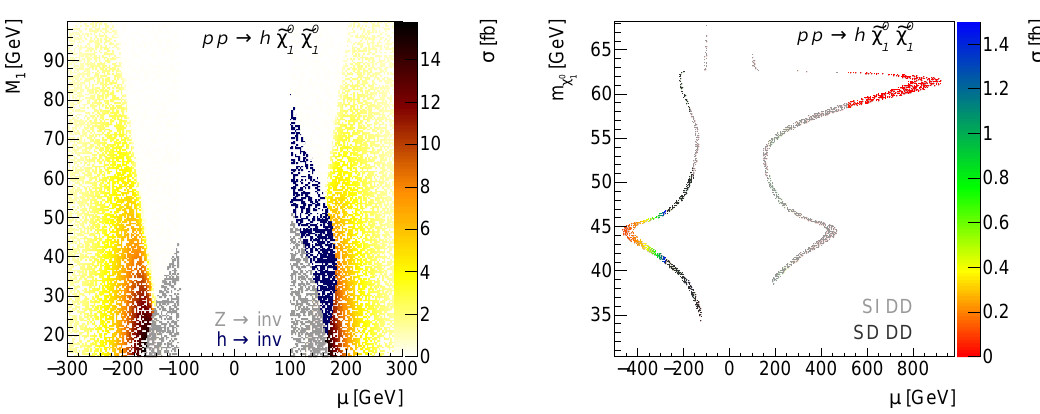
Figure 14: Cross section for the mono-Higgs process in the µ − M fulfilling the chargino mass bound, shown with the limits on invisible Z and Higgs decays. Right: points also predicting the correct relic density, shown with DD